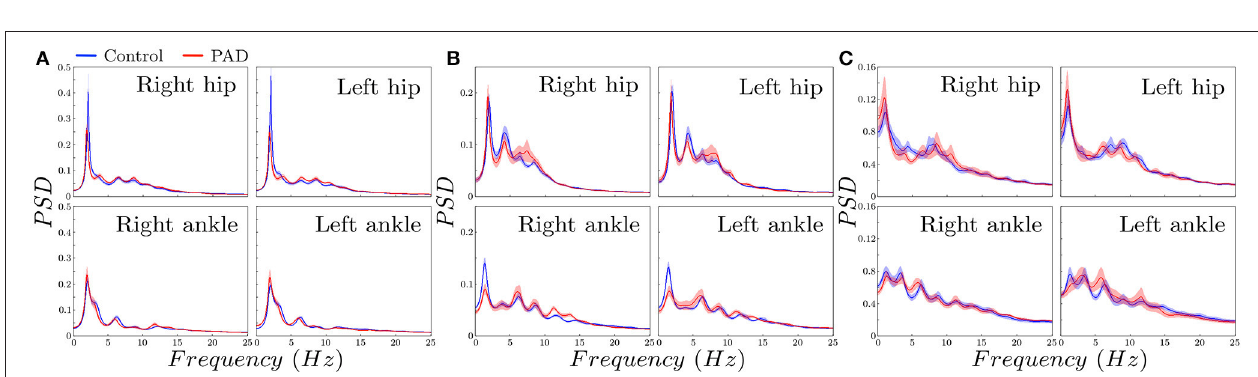
FIGURE 5 | Spectral envelopes estimated with LPC (mean ± std using bootstrap) for control subjects and PAD patients. (A) vertical, (B) Anterior posterior, (C)